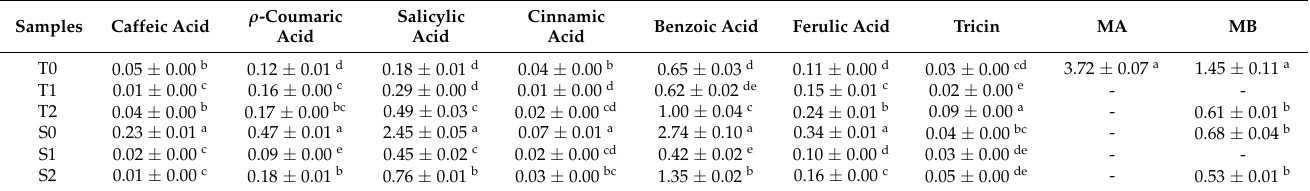
Table 2. Phenolic compound ( µ g/g DW) and momilactone (ng/g DW) contents of rice under salinity